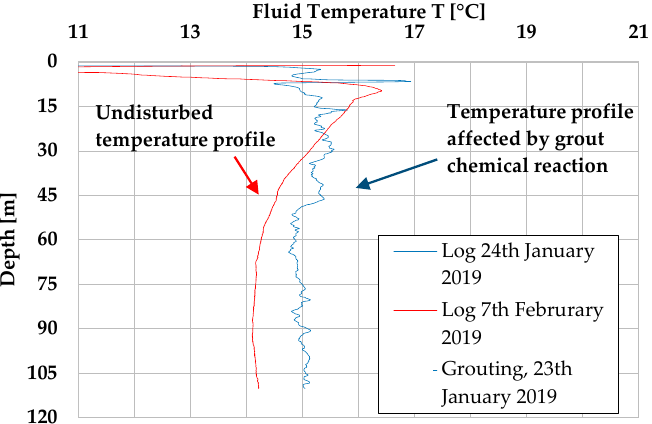
Figure 5. Vertical ground temperature profiles at the FAE-2 pilot BHE during the grout hydration period (24 January profile) as compared to the one at the end of the chemical reaction, 15 days later.